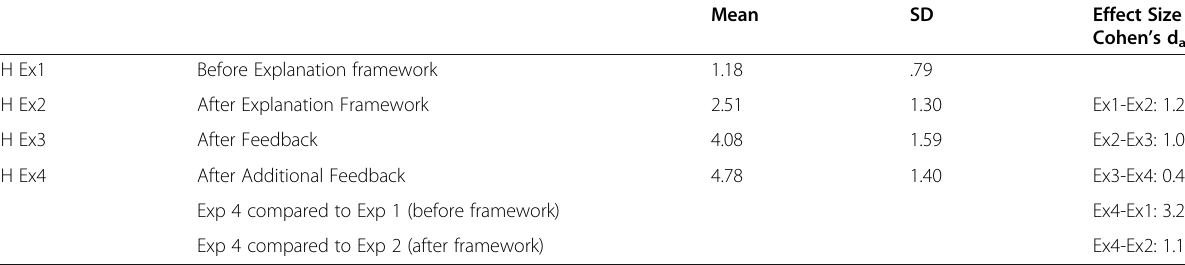
Table 4 Students pH science ideas across an evolving explanation ( n = 51)*